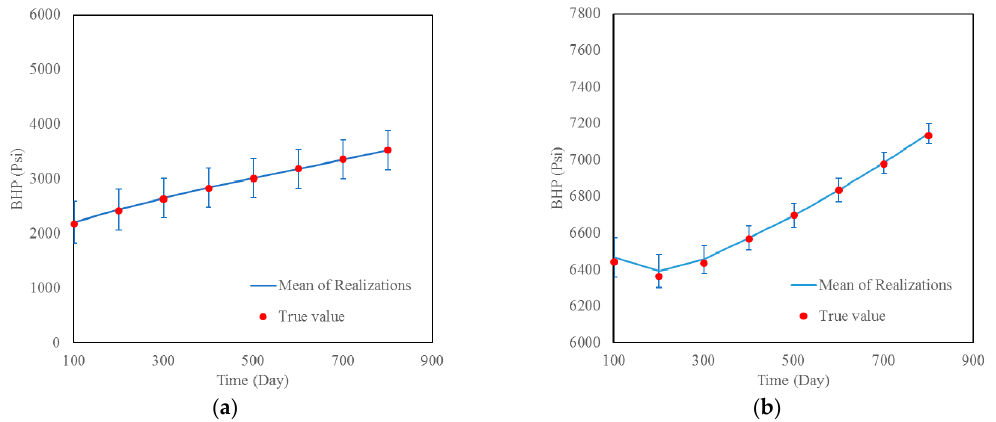
Figure 12. The predictions (mean with the 95% confidence intervals) after history-matching: ( a ) Producer BHP; ( b ) Injector BHP.